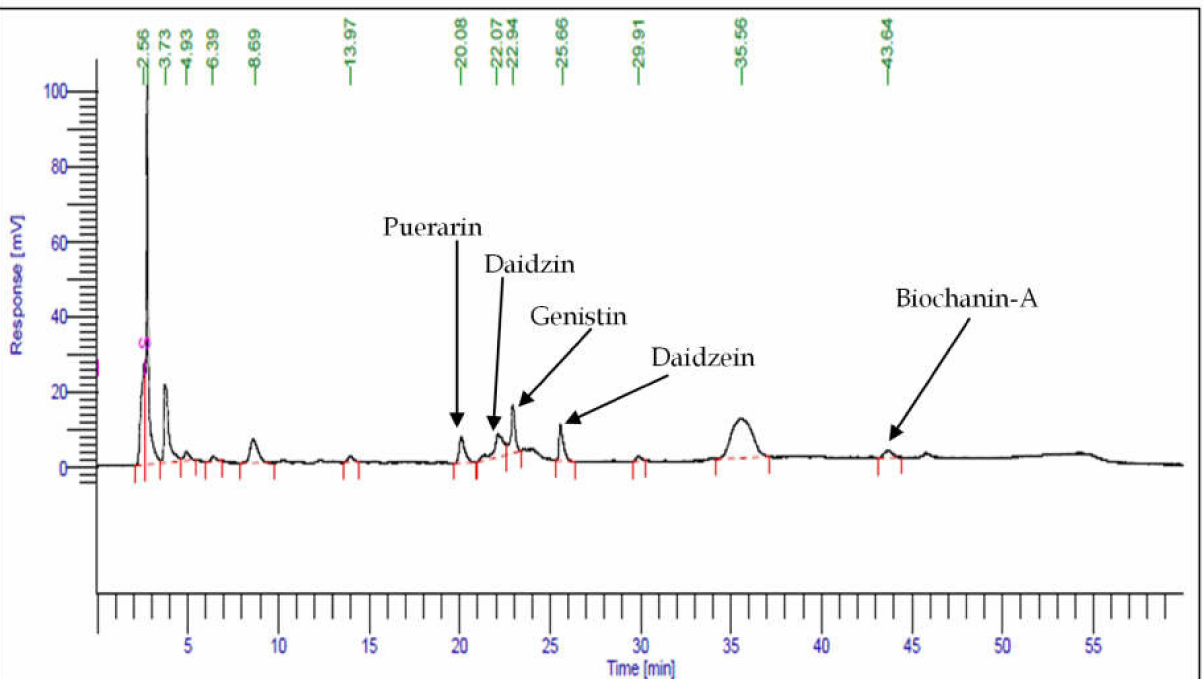
Figure 4. HPLC chromatogram of PEC elicited (100 mg/L) shoots of P. tuberosa